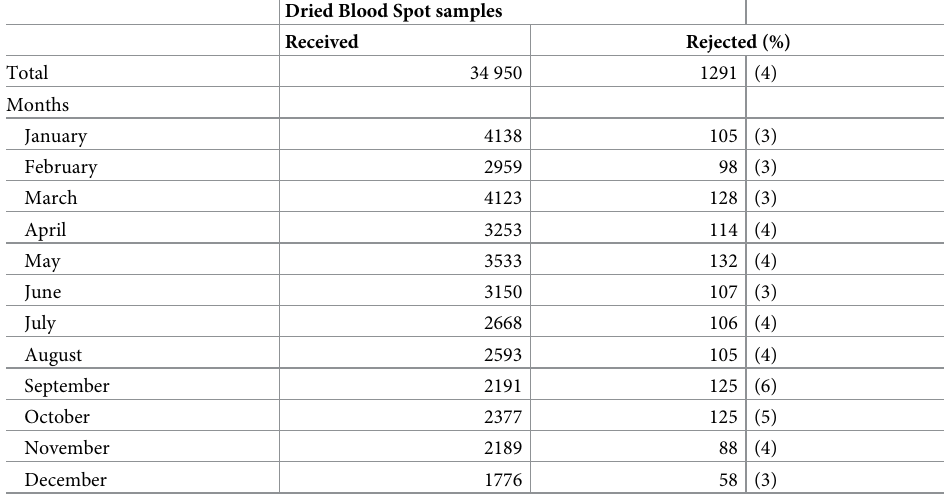
Table 1. Number and proportion of rejected DBS samples at the NMRL, between January and December 2017.